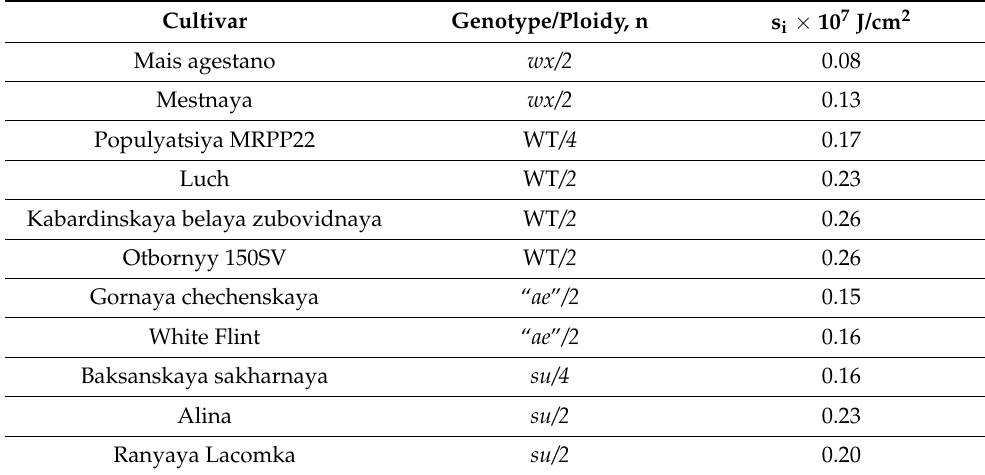
Table 4. The values of free surface entropy (s i ) on the face side of crystalline lamellae in maize starches with different genotypes. Cultivar Genotype/Ploidy, n s i × 10 7 J/cm 2 Mais agestano wx/2 0.08 Mestnaya wx/2